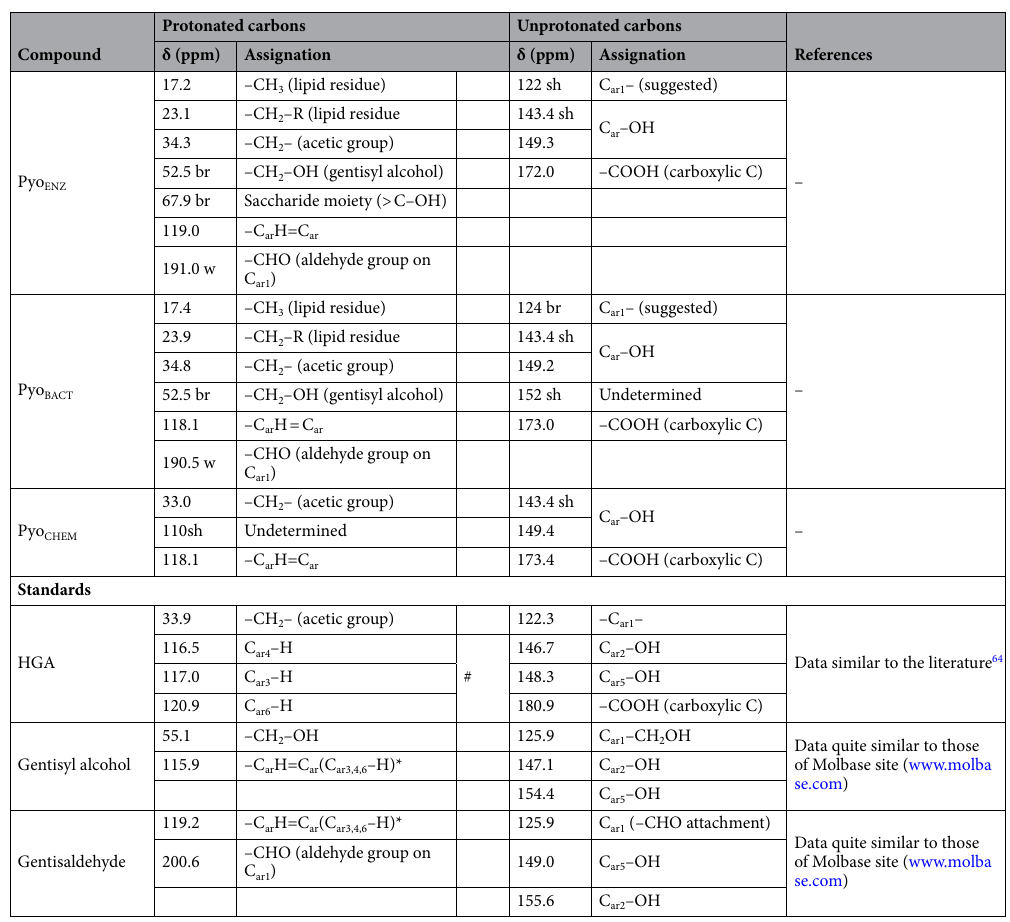
(Fig. 2, data framed) indicates a correct -CH 2 -COOH substitution for Pyo ENZ and Pyo BACT with a value of 1/6, whereas a loss of the carboxylic moiety on Pyo CHEM structure (ratio 1/10) has occurred. More information on the polymer assembly was necessary to elucidate the mechanism of polymerization and the types of linkage between the rings, i.e. C ar -C ar (aryl carbon) or/and C ar -O-C ar (aryl ether) linkages. FTIR analyses. Pyo 13 C-NMR spectra, hence the study BACT and Pyo ENZ exhibited very similar FTIR and was focused on the Pyo ENZ and Pyo CHEM absorptions (Fig. 5S) noting that the spectrum of Pyo CHEM was better resolved in reason to its less high M w (2,300 Da, Table 2). The peaks at the following wavenumbers and their corresponding structures included the bands for Pyo ENZ and Pyo CHEM , respectively at ( i ) 3401 and 3278 cm −1 (broad) indicative of the –OH stretch of polymeric structures; (ii) two smaller bands for each compound at 2960 (Pyo ENZ ) and much more intense at 2925–2927 cm −1 (Pyo CHEM ), which corresponded to stretching vibrations of the aliphatic C ar –H groups; (iii) 1711 and 1720 cm −1 quite resolved here and ascribed to carbonyl stretching (C=O) of the -COOH group, these bands were however absent on other microbial pyomelanin 29,37 ; (iv) 1623 and 1656 cm −1 absorptions that were described as typical for aromatic C=C conjugated with C=O groups (quinones), with a stronger response in Pyo CHEM ; (v) 1384 and 1385 cm −1 (both minor) would be assigned to the O–H bond of the hydroxyl groups attached to the ring; and (vi) strong bands at 1197 (Pyo ENZ ) and 1222 cm −1 (Pyo CHEM ) of the phenolic-OH links. Presence of N in Pyo and Pyo . ENZ BACT